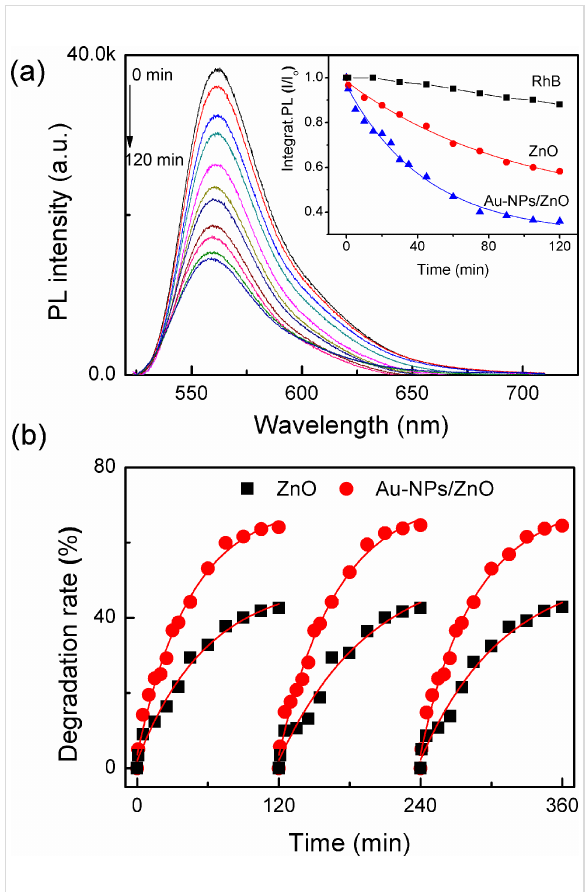
Figure 5: (a) Photoluminescence (PL) spectra of aqueous RhB solu- tion in the presence of as-deposited ZnO and Au NP/ZnO structures under visible-light irradiation. The inset shows the percentage of the PL quenching. (b) Photocatalytic activity of all samples under periodic visible irradiation. The experiment was repeated three times.